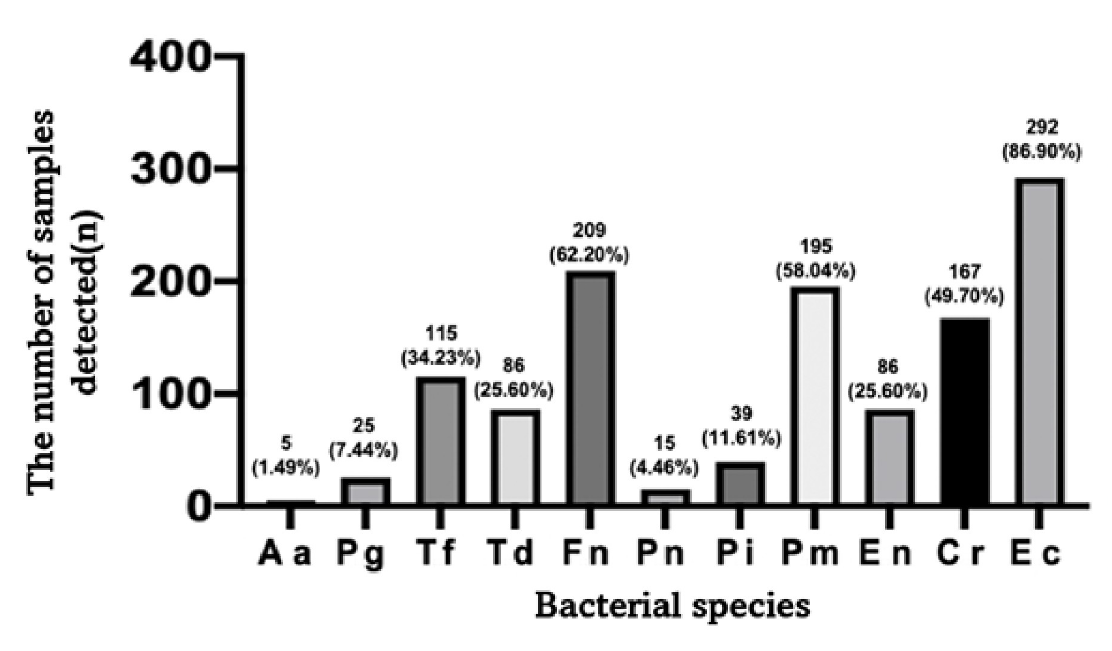
Fig 2. Overall prevalence of bacteria in the reversible and irreversible groups. Bars represent the number of samples that each bacterial species was detected and the percentage of the number of samples detected to the number of total samples (%). Fn , Pm , and Ec showed high prevalence at over 50%, whereas Aa , Pg , and Pn showed low prevalence at less than